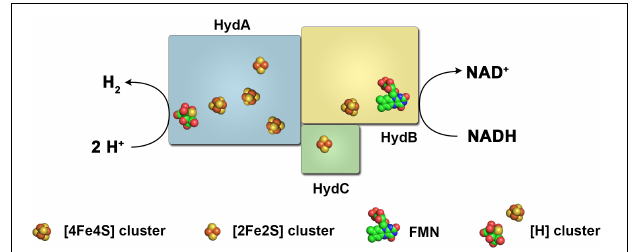
FIGURE 5 | Subunit architecture and cofactor content of the NADH-dependent hydrogenase of S. wolfei . This enzyme resembles in the overall subunit architecture electron bifurcating/confurcating hydrogenases that utilize NADH and reduced ferredoxin in an energetically coupled reaction to produce H 2 (or vice versa ). The hydrogenase of S. wolfei putatively lacks three iron–sulfur clusters in the subunit HydB and utilizes NADH alone for H 2 production, thus not using